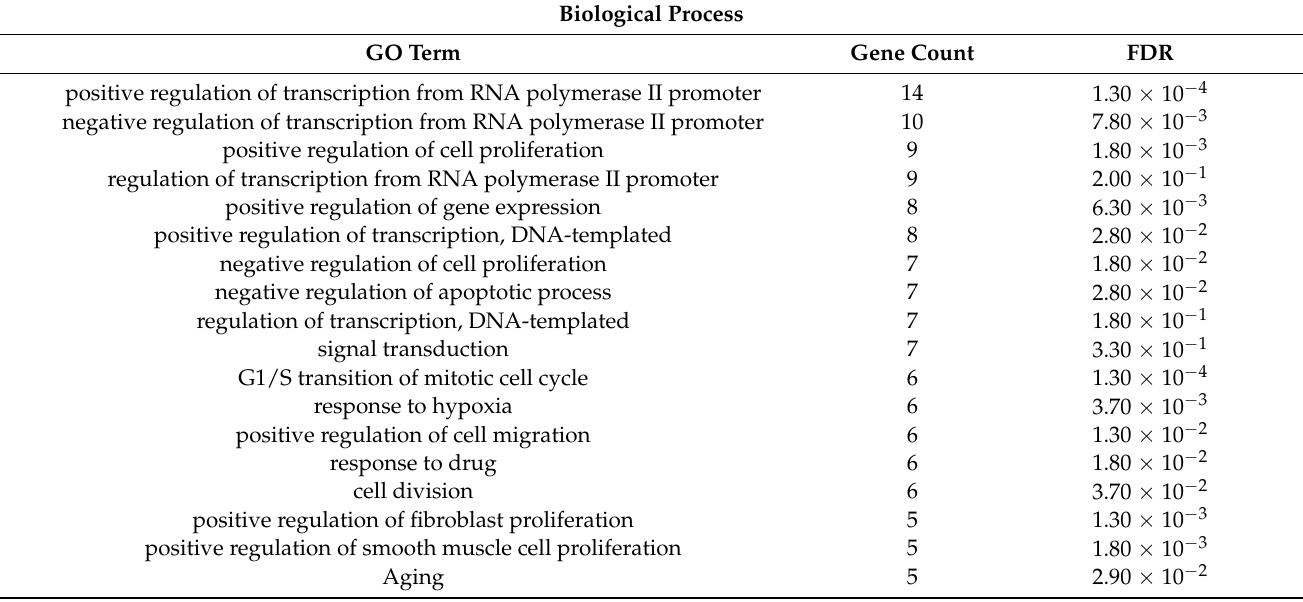
Table 3. Gene Ontology (GO) terms enrichment analysis of the shared target genes downstream